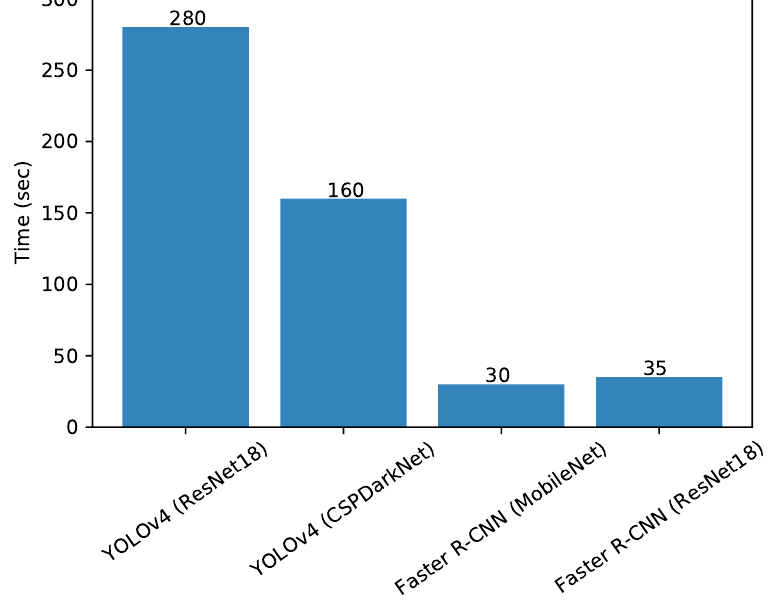
Figure 6. Training Time Per Epoch for each Implemented Computer Vision Object Detection Model.